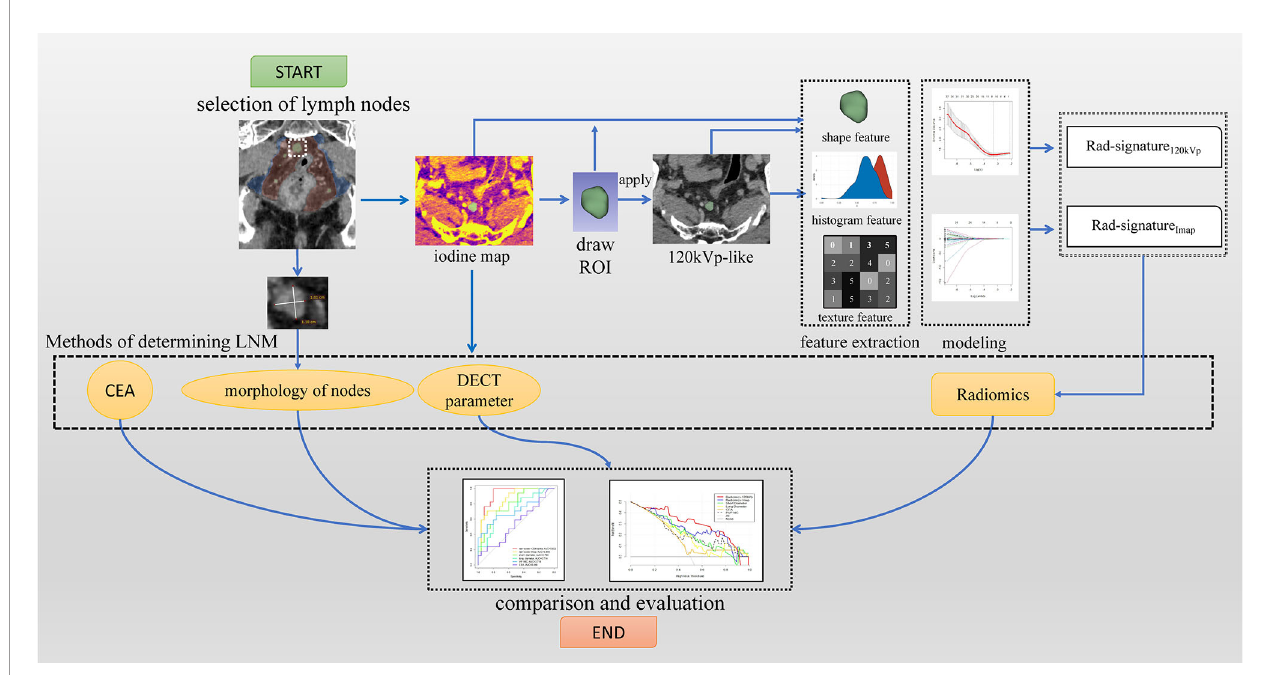
FIGURE 3 | A study work fl ow. Imaging processing began by selecting the largest lymph nodes; fi nally, four categories of methods were